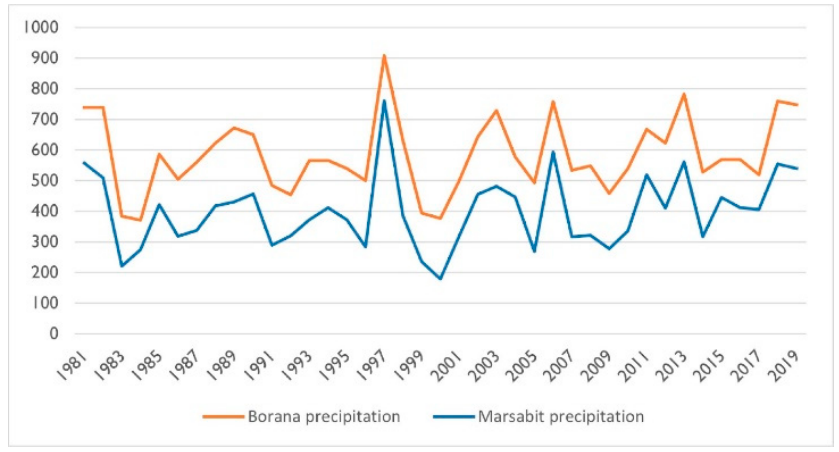
Figure 5. Average annual precipitation for the years 1990–2020 in the Marsabit region (blue) and in the Borana region (orange) (Source: CHIRPS dataset (Funk et al., 2015)).